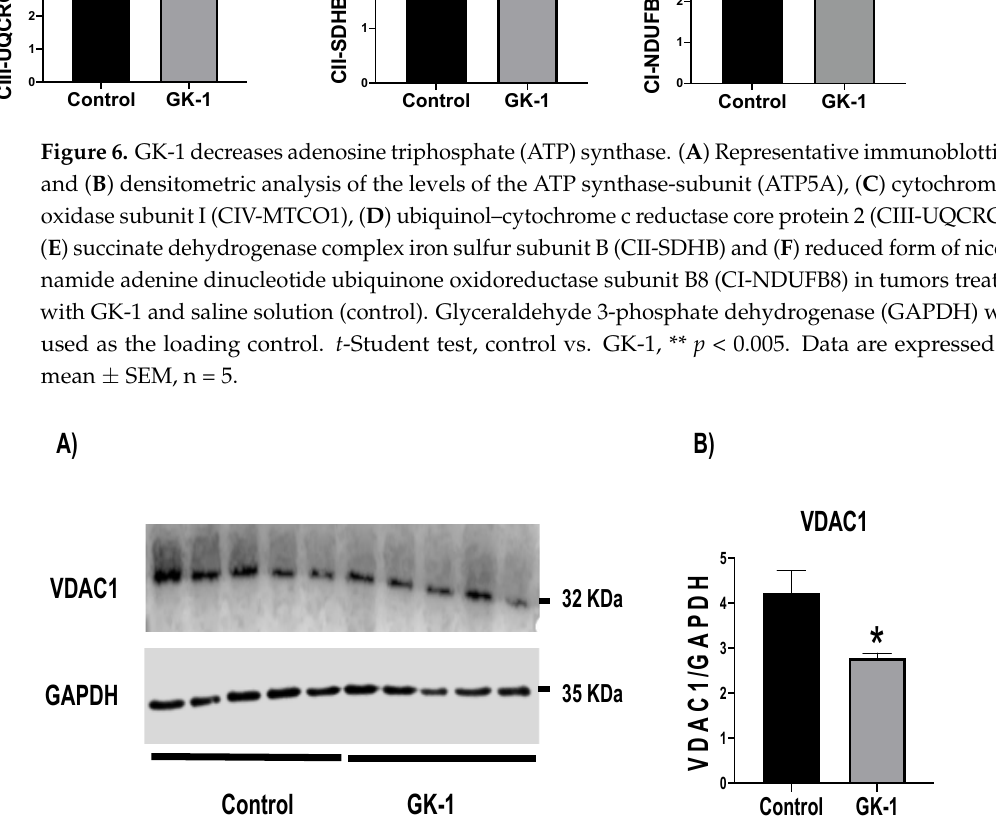
Figure 7. GK-1 decreases voltage-dependent anion channel 1 (VDAC1) expression. GK-1 decreases VDAC1 in triple-negative breast tumor. ( A ) Representative immunoblot and ( B ) densitometric analy- sis of mitochondrial mass marker VDAC1. Glyceraldehyde 3-phosphate dehydrogenase (GAPDH) was used as the loading control. t-student test, control vs GK-1, * p < 0.05. Data are expressed as mean ± SEM, n =